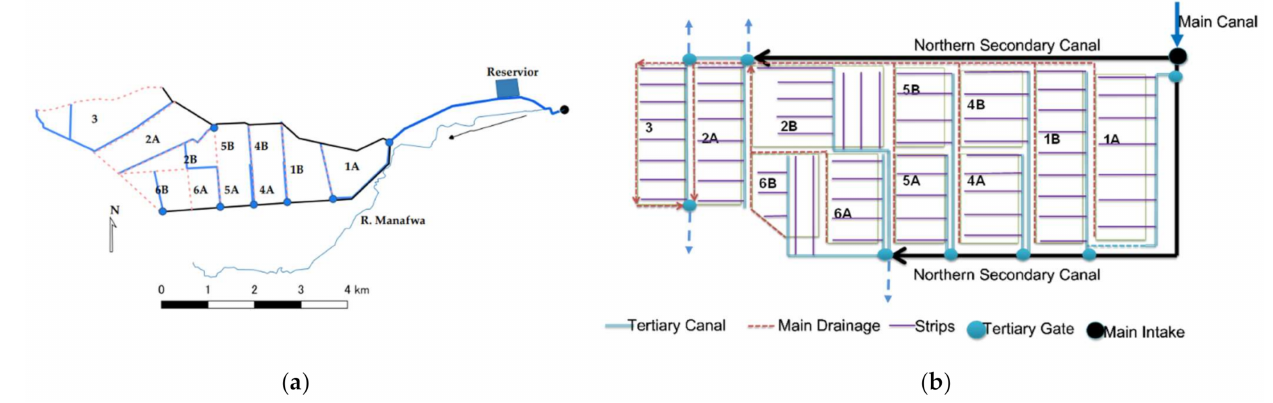
Figure 1. The actual layout of the Doho rice scheme ( a ) and the schematic layout of the Doho rice scheme ( b ). The strip is the last terminal